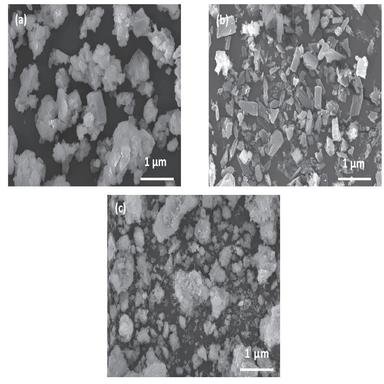
The FESEM images of produced MgO-Y2O3 nanocomposite at diferent Mg+2 ion content (a) 80 Mg:20Y, (b) 50 Mg:50Y and (c) 20 Mg:80Y annealed at 600 C for 2 h.